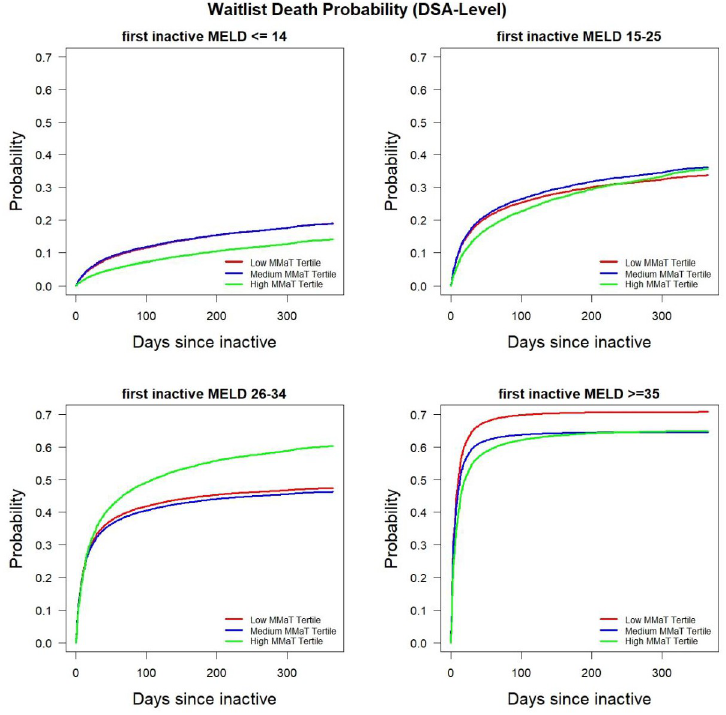
Fig 4. Probability of death among inactive waitlist candidates stratified by candidate MELD group and MMaT at the transplant center-level.